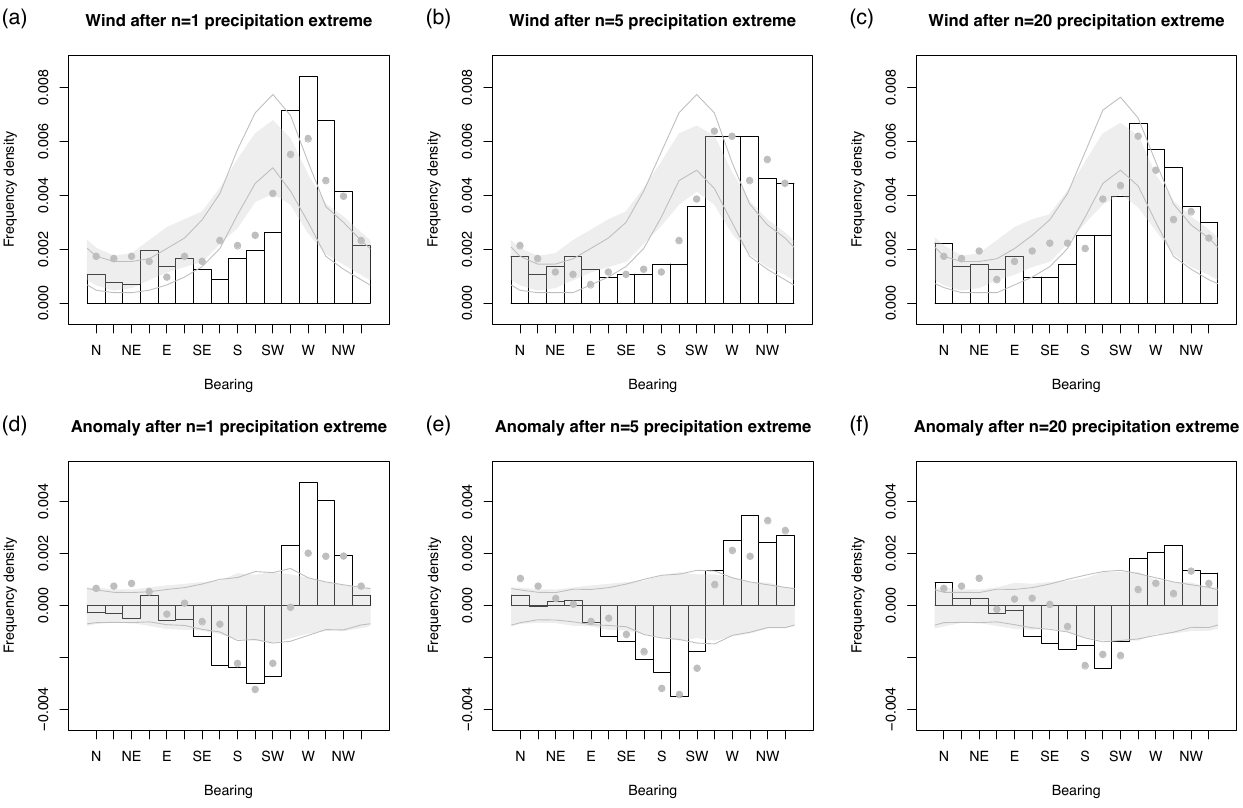
Fig. 3. Wind directions following extreme (bars for current climate, dots for future) and random samples (95% density range, shaded for current climate, outlined for future) of n -day precipitation sums (upper row) and their anomaly (lower row) with reference to the